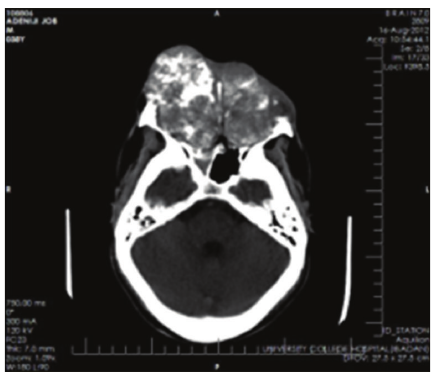
Figure 6: Axial CT showing the mass pushing out the orbital contents.